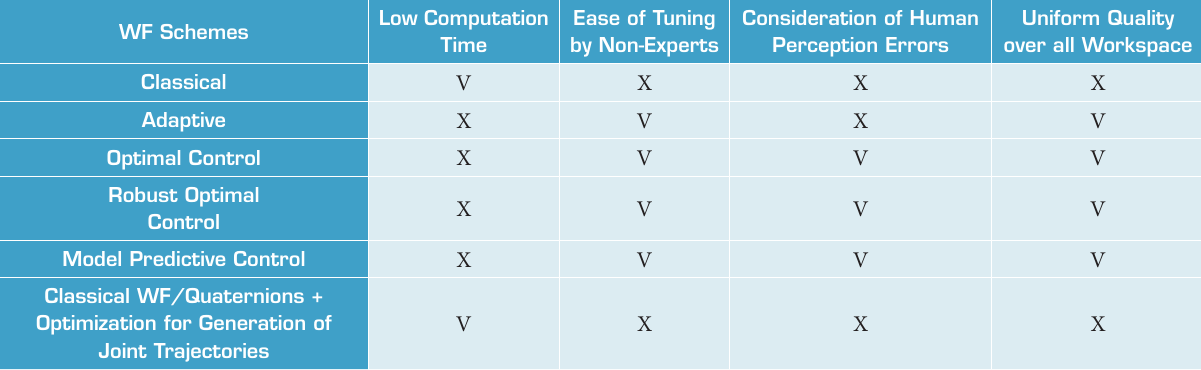
Table 1. Summary of the characteristics of existing Washout Filter (WF)